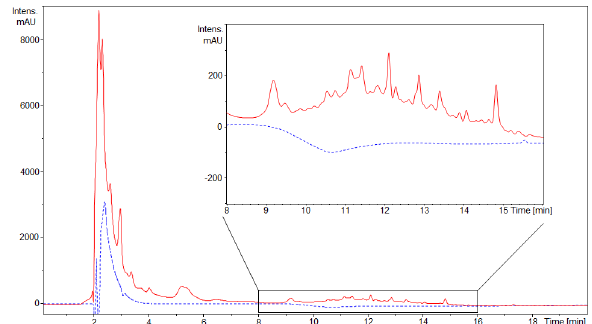
Figure 5. Temporal evolution of relatively apolar products in a Gly/AS mixture (1.5 M Gly, 3 M AS). 2 Fig. 5. Temporal evolution of relatively non-polar products in The blue (dotted) chromatogram was recorded immediately after mixing and the red (solid) 3 a Gly/AS mixture (1.5MGly, 3MAS). The blue (dotted) chro- chromatogram 116.05 h after mixing (sum of absorbances at wavelengths between 350 and 400 nm). 4 matogram was recorded immediately after mixing and the red (solid) chromatogram 116.05h after mixing (sum of absorbances at wavelengths between 350 and 400nm).